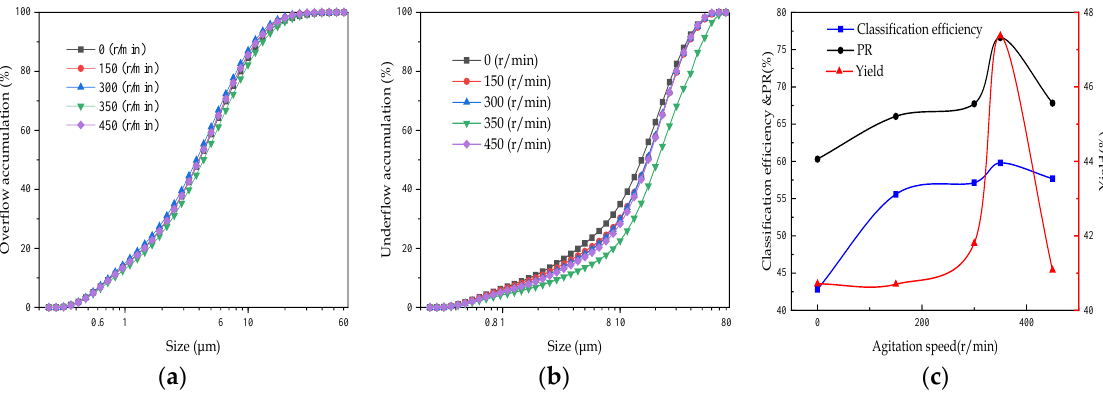
Figure 6. ( a ) Overflow particle size; ( b ) underflow particle size; ( c ) classification index. Experiment on the effect of agitation speed condition.